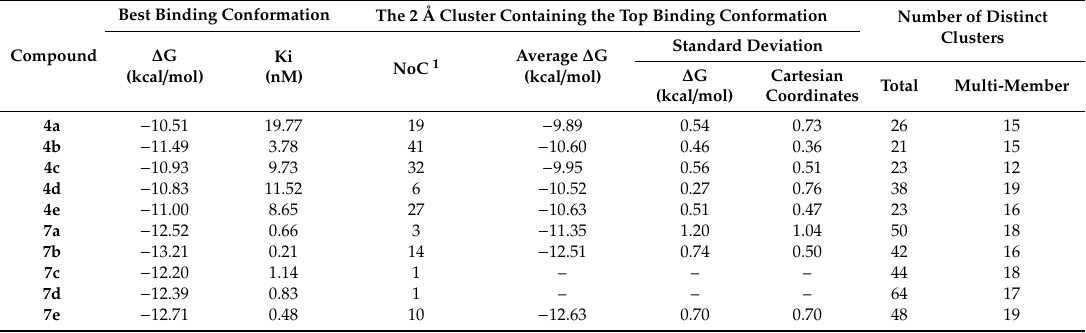
Table 3. The predicted binding interaction energy ( ∆ G, kcal / mol), the consequent inhibition constant (Ki, nM) and the cluster analysis containing the best conformation of each compound given by